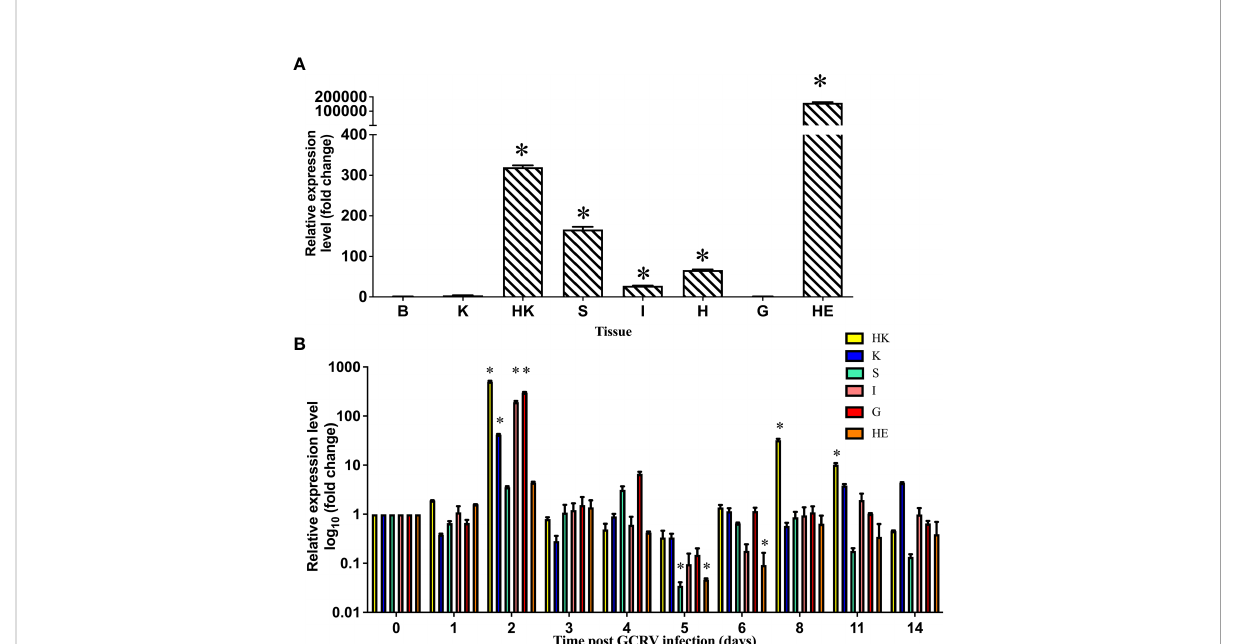
FIGURE 1 Expression distribution of serpina1 mRNA in various tissues of grass carp before and after infection. (A) Expression distribution of serpina1 mRNA in the brain (B), kidney (K), head kidney (HK), spleen (S), intestine (I), heart (H), gill (G), and hepatopancreas (HE) of healthy grass carp. The expression level of the serpina1 gene in the brain was taken as “ 1 ” , and the relative expression levels of other tissues were calculated. The horizontal coordinates indicate the different tissues, and the vertical coordinates indicate the relative expression. (B) Changes in the expression of serpina1 mRNA in the HK, K, S, G, I, and HE of grass carp after GCRV infection. The expression before infection (day 0) was taken as “ 1 ” , and the relative expression levels of the serpina1 gene after infection were calculated. The horizon coordinates indicate different infection times, and the vertical coordinates indicate the relative expression level. Different colors indicate different tissues. “ * ” indicates